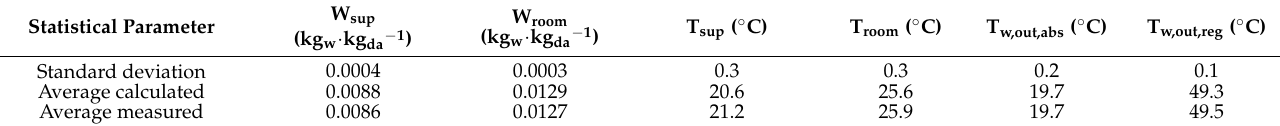
Table 5. Statistical comparison between measured and simulated data of some parameters of the system.